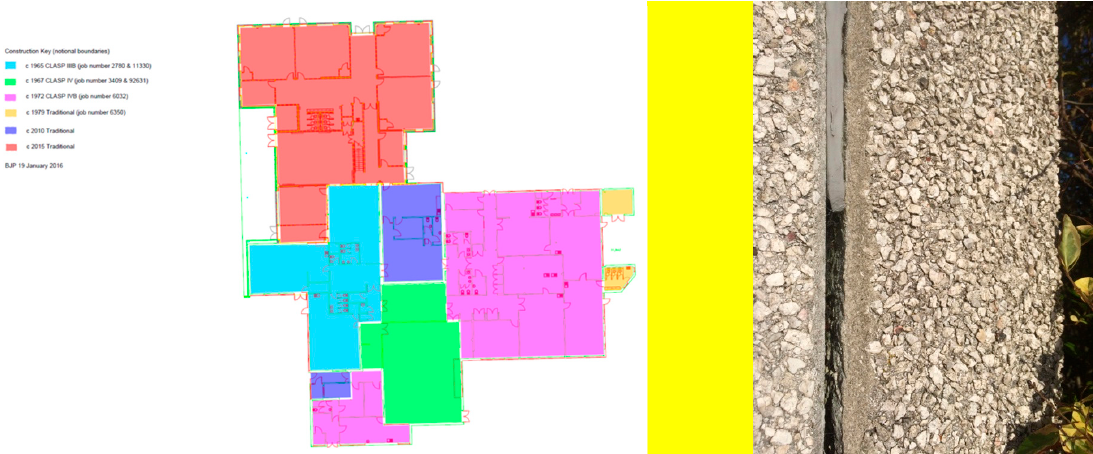
Figure 3. Plan view of UK school building and a portion of the precast skin requiring retrofit on the south façade of the plan view.